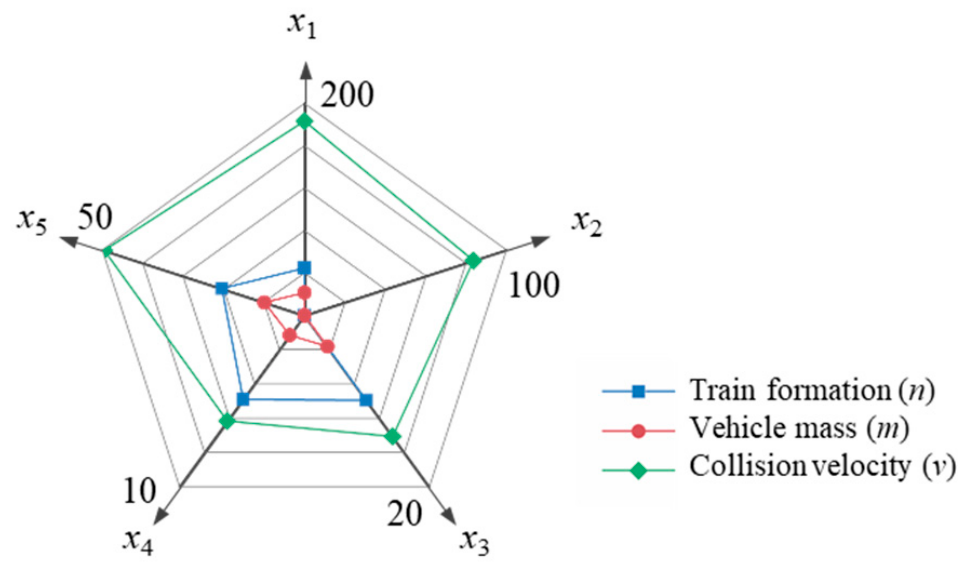
Figure 15. Sensitivity of design parameters to the displacement response of each stage.